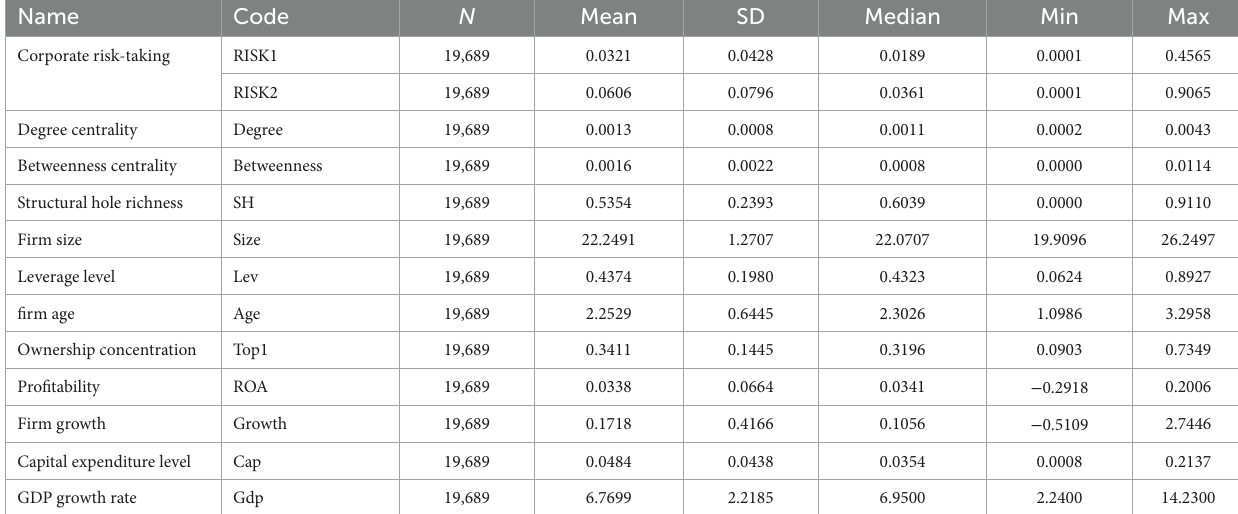
TABLE 2 Descriptive statistics of main